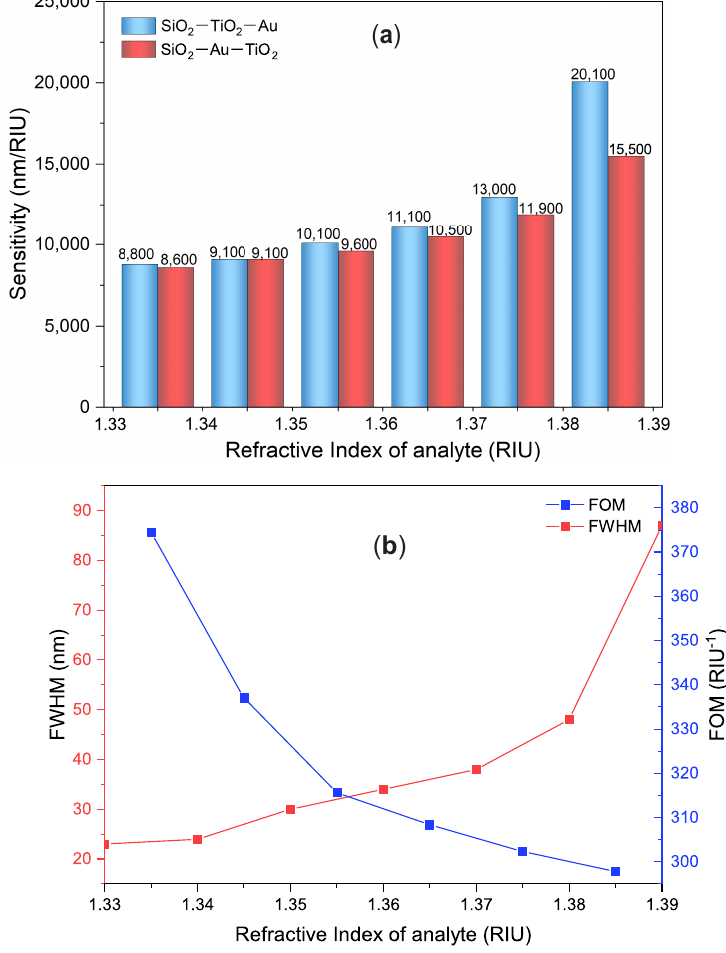
Figure 8. ( a ) The wavelength sensitivities of S1 and S2 heterostructures in each step of analyte’s RI; ( b ) The calculated FWHWs and FOMs of S1 and S2 in each step of analyte’s